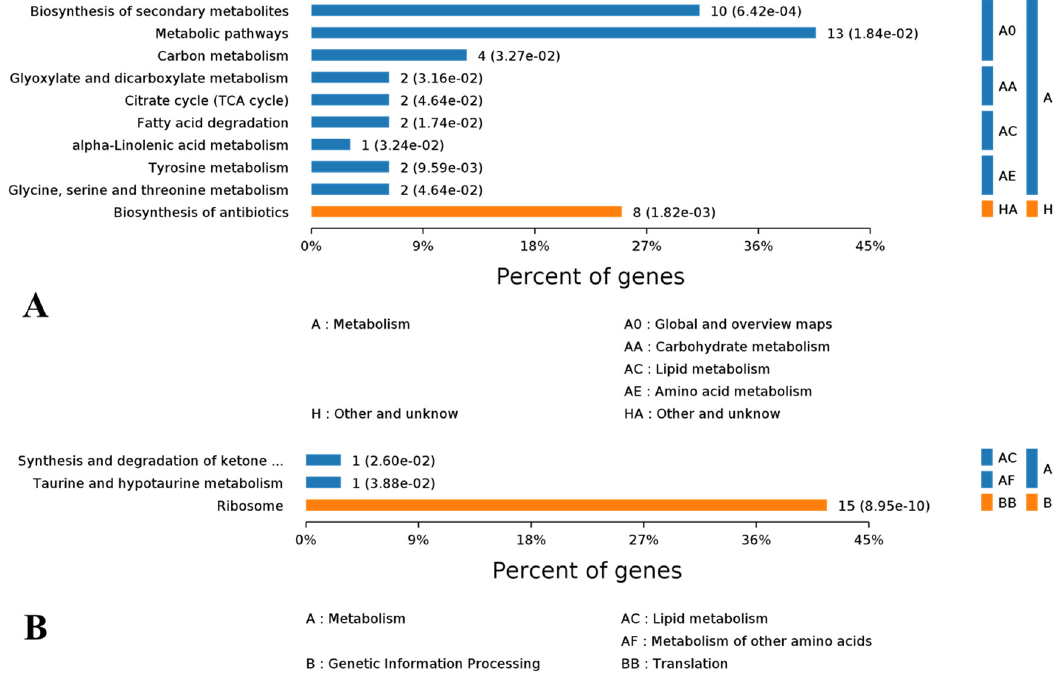
Figure 8. KEGG enrichment of DEPs and hierarchical belonging of each enriched pathway to upper level pathways. ( A ) Pathway classification of up regulated DEPs. ( B ) Pathway classification of down regulated DEPs.